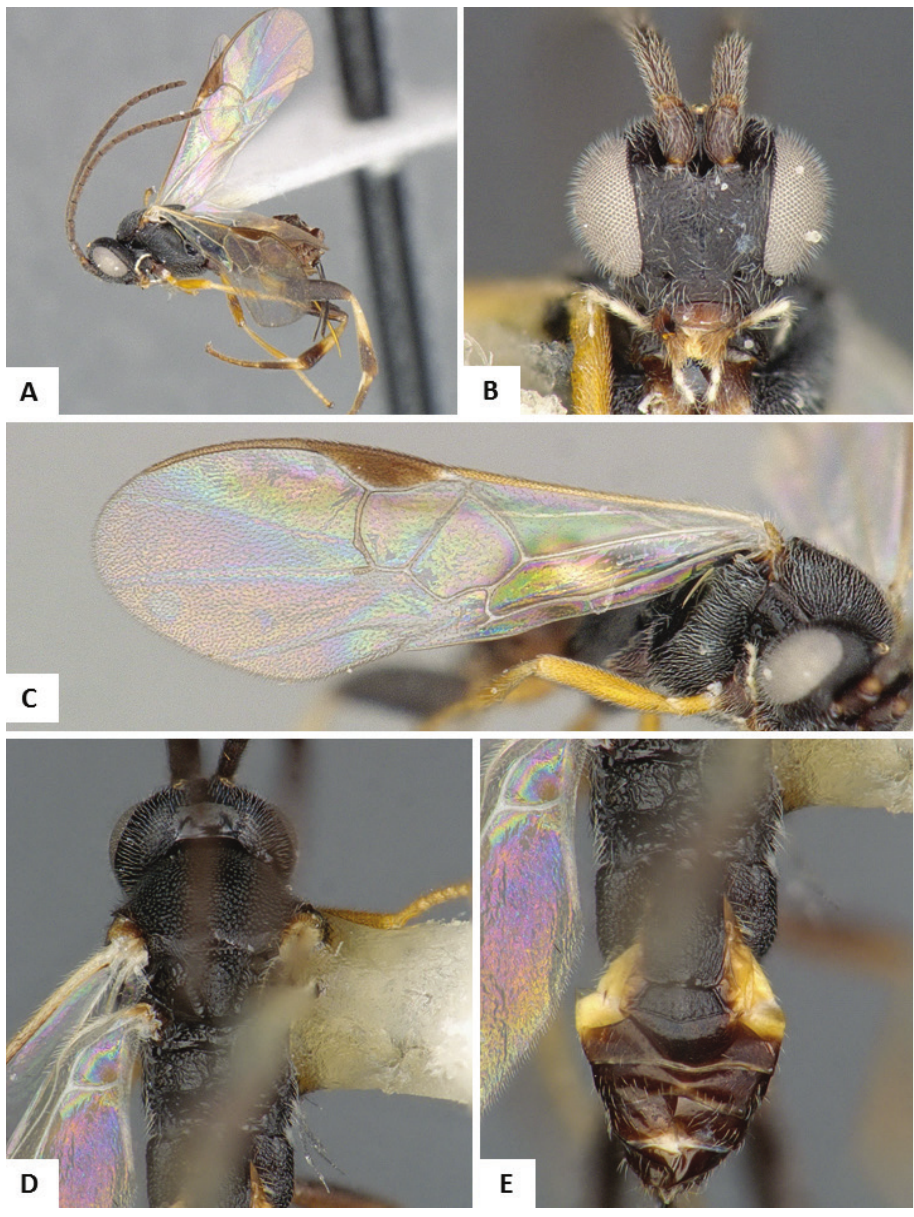
Figure 7. Apanteles hemara female specimen from Madagascar (Voucher code: